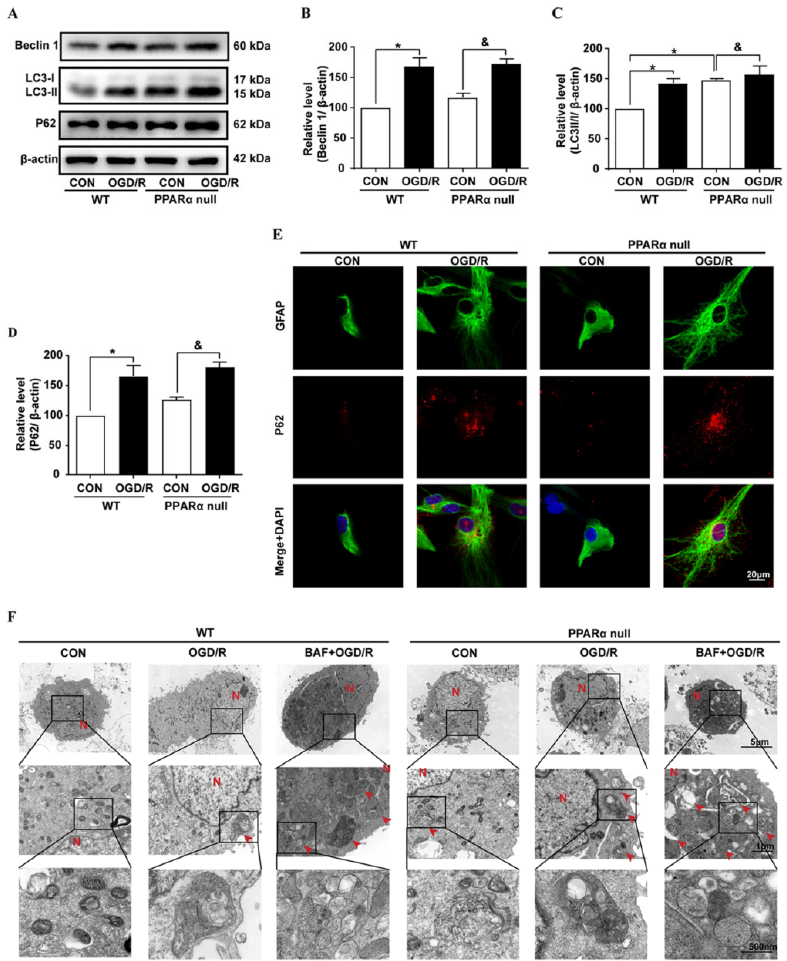
Figure 3. PPAR α dysfunction hinders autophagic flux in primary mice astrocyte after exposure to OGD/R. ( A – D ) The immunoblotting analysis and quantification of Beclin1, p62, and LC3-II in WT and PPAR α -deficient astrocyte exposure to OGD/R. The data are representative of the three independent experiments and are expressed as the mean ± SEM. * p < 0.05 vs. WT normal control; & p < 0.05 vs. PPAR α deficit control. ( E ) The representative photographs of immunofluorescence staining of GFAP (green) and p62 (red) with DAPI (blue) staining in the WT and PPAR α -deficient astrocytes after exposure to OGD/R. ( F ) The representative ultrastructural morphology of autophagic vesicles (autophagosome/autolysosome) was observed by TME in WT and PPAR α -de fi cient astrocytes after exposure to OGD/R, whether with BAF treatment or not. Boxes: areas selected for higher magni fi - cation. Red arrows indicate autophagic vesicles and N indicates nucleus. OGD/R means OGD for 6 h and reoxygenation for 24 h.